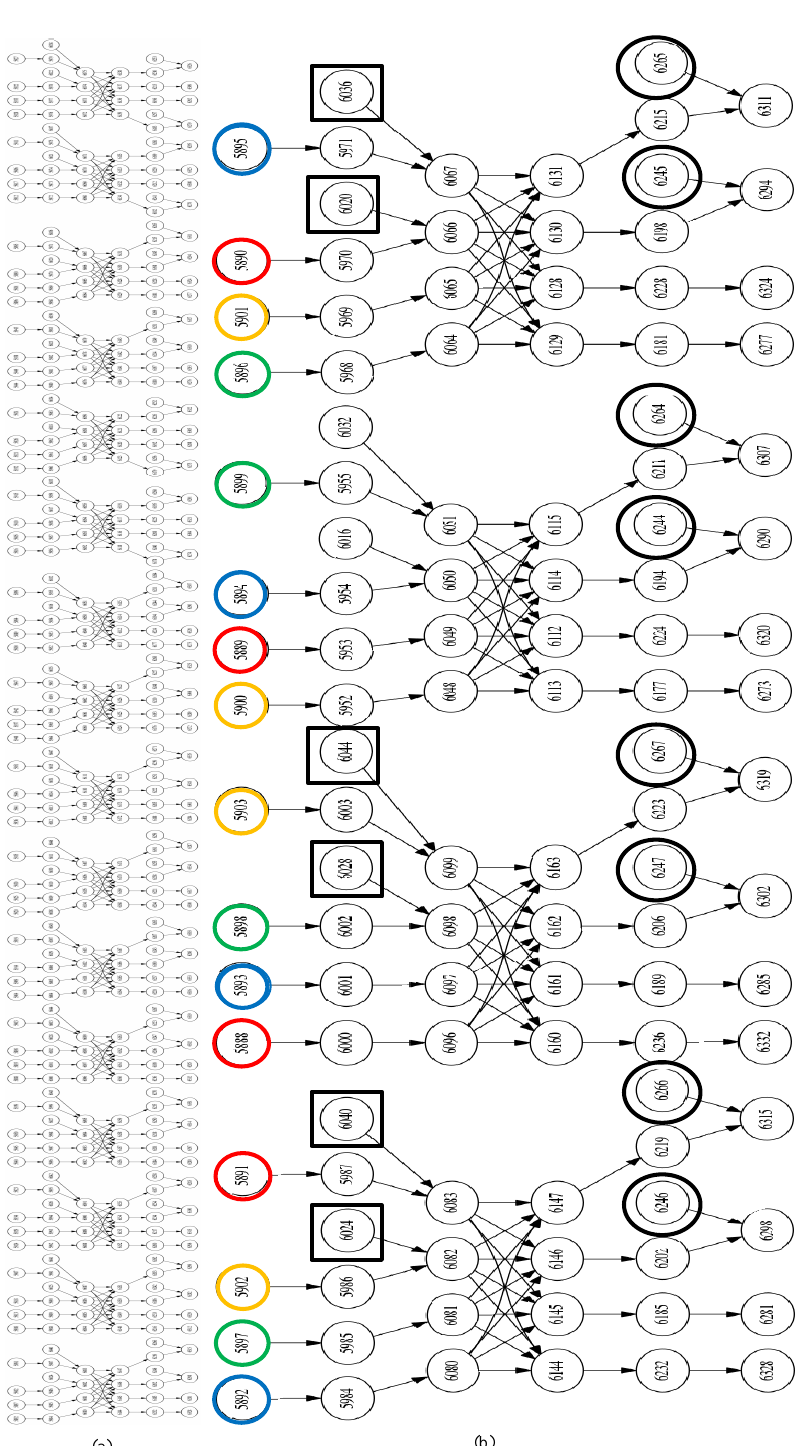
Figure 10: Graph corresponding to the distinguisher D 2 at the 25-th round on GIFT; (a) The complete graph from the tool (used to extract the keys of round 28), (b) One independent computation chunk/